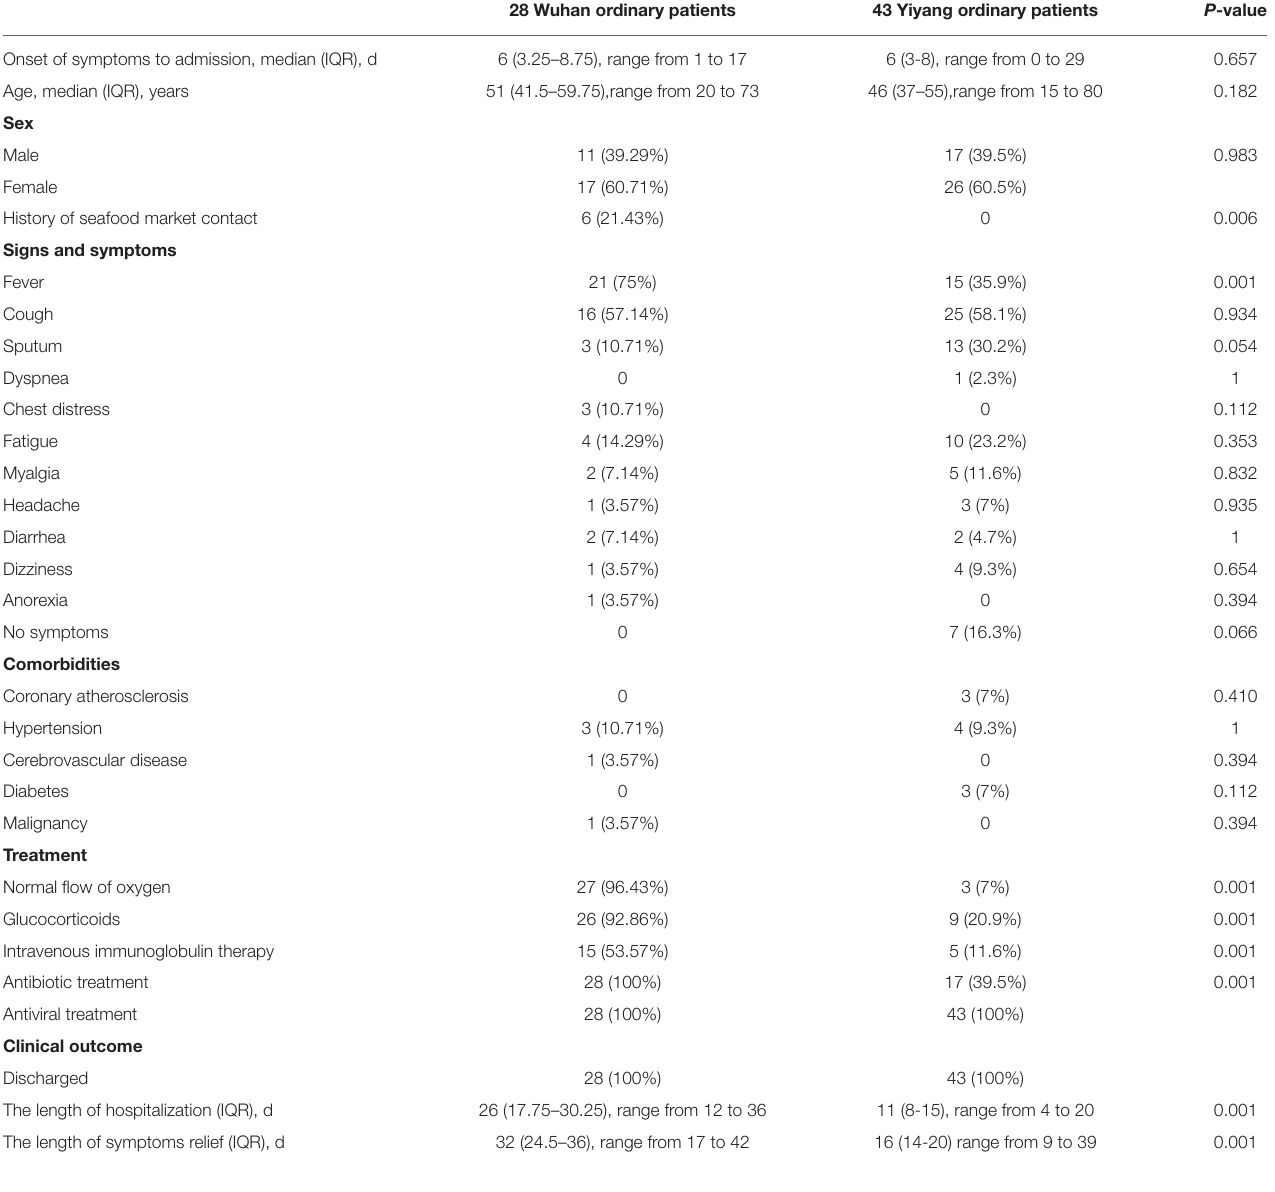
TABLE 3 | Demographic, clinical characteristics, treatment, and outcome of ordinary patients with moderate-type COVID-19 from Wuhan and